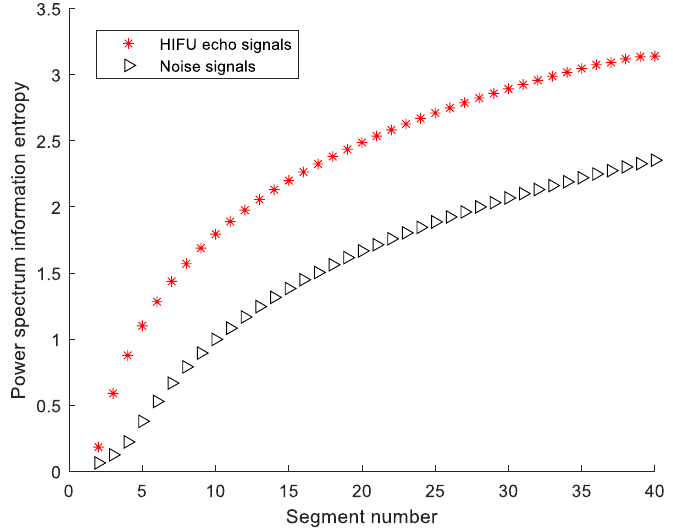
Figure 6. The average power spectrum information entropy under each segment number.